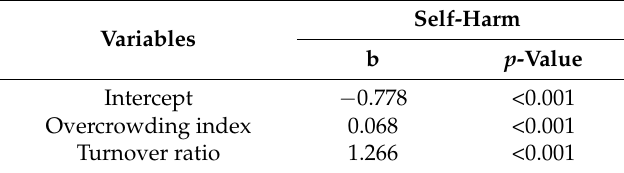
Table 1. Meta-regression of the effect of overcrowding and turnover on self-harm